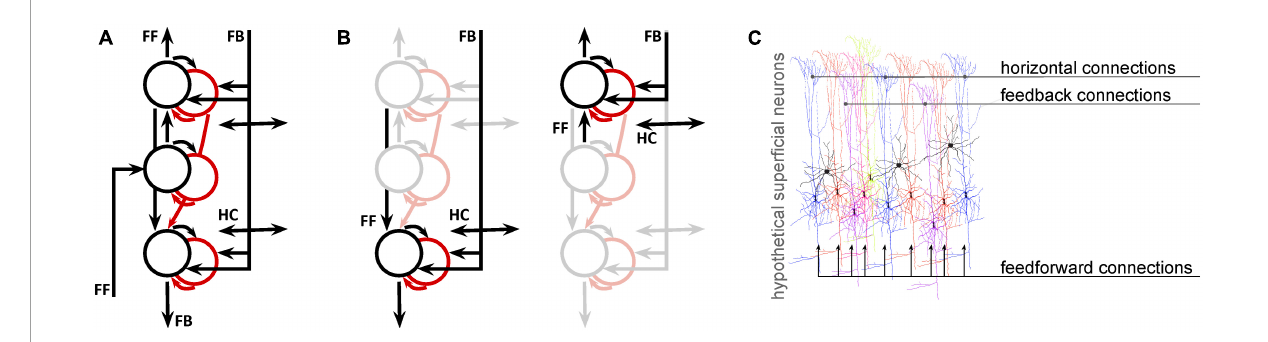
FIGURE1 Even for fMRI data with sub-millimeter resolution, analysis and interpretation need to address the fact that multiple signals coexist at every location. (A) A simplified network model of deep (toward the bottom), middle, and superficial neural populations (circles: black = excitatory; red = inhibitory) and connections (arrows) in primary visual cortex. Proportions are not represented. (B) Copies of the first panel highlight the fact that, at the mesoscopic level (0.1–0.5 mm), neural populations receive both feedforward and feedback connections. (C) At the microscopic (single-neuron level) it is likely that different neurons receive different projections in different proportions. This is an entirely hypothetical illustration of superficial pyramidal neurons receiving both feedforward, horizontal (intermediate-range), and feedback (long-range) inputs, color coded according to the degree to which each neuron is modulated by each type of input. This is not intended to have specific anatomical validity, but to illustrate the likelihood that even the best-localized population has a heterogeneous feedforward/feedback balance, allowing simultaneous representation of different potential behavioral or perceptual states.